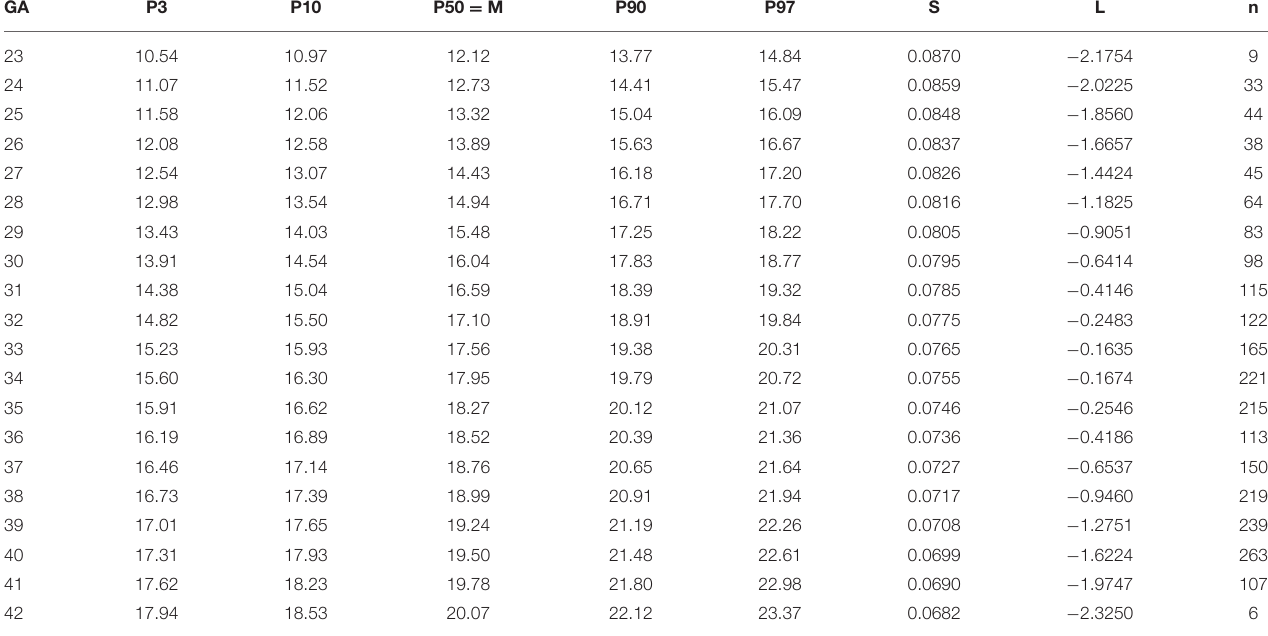
TABLE 1 | LMS parameters of models of transfontanellar EED (fEED) for girls.